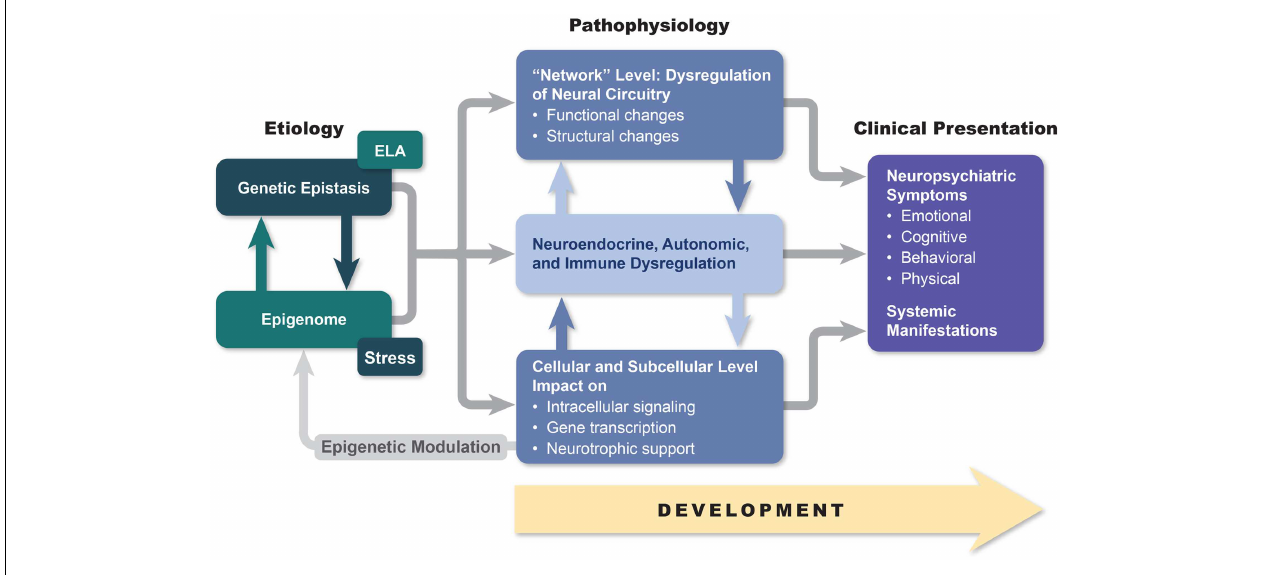
provide a path to greater treatment success. Our model acknowledges pathophysiological diversity of mood disorders and provides opportunity for individualized treatment approaches based on the link between symptom constellations, genetics, and specific endo-phenotype